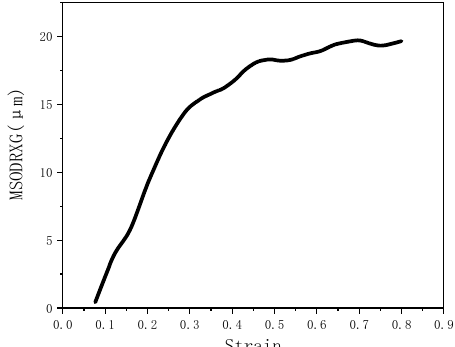
Figure 15. Relationship between MSODRXG and strain.